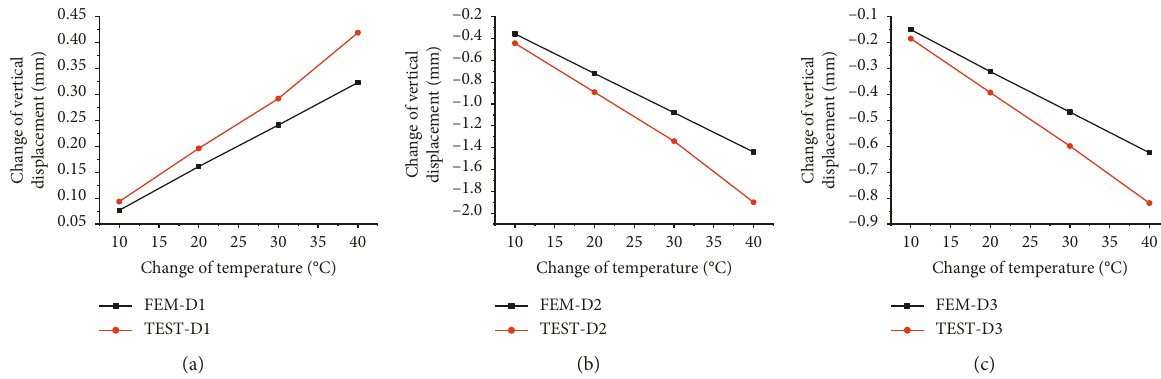
Figure 18: Comparison of the change in nodal displacement in the experiments and finite element numerical simulation under the half- span load. Displacement change of (a) D1, (b) D2, and (c) D3 under the half-span